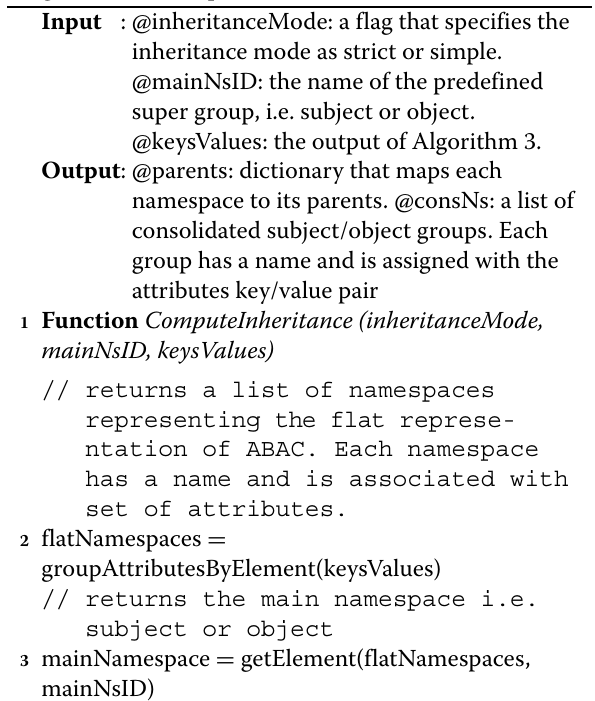
Algorithm 4: Compute inheritance between